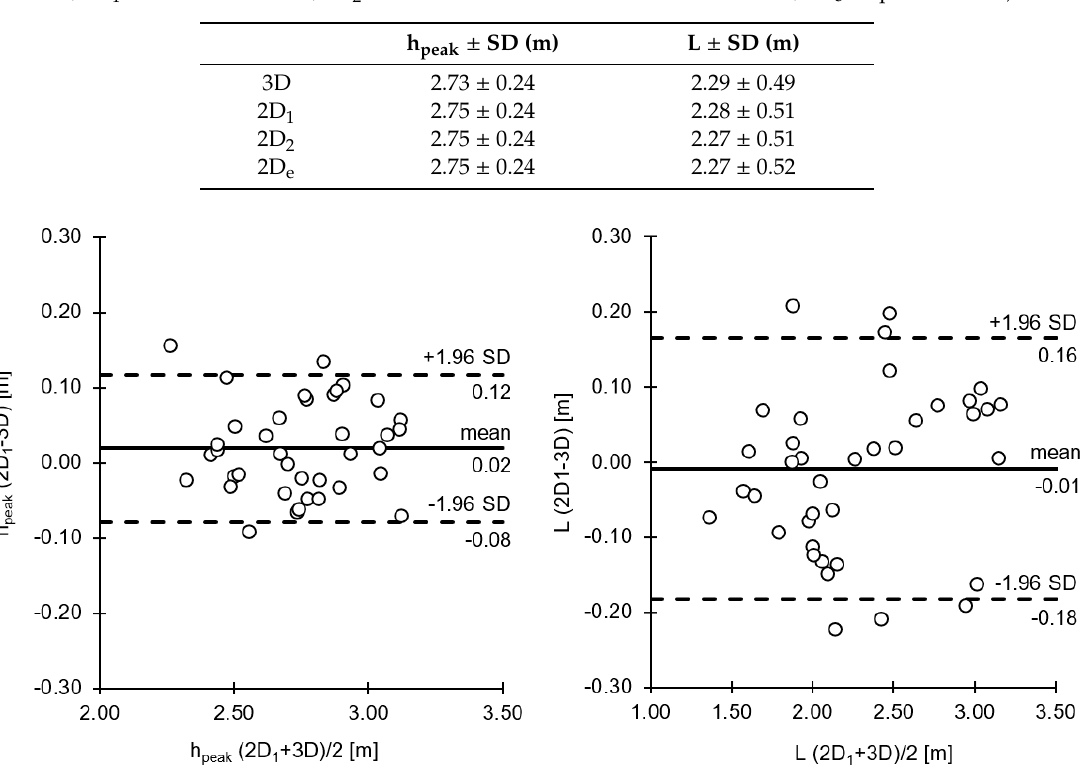
Table 1. Mean ( ± standard deviation) of peak height (h peak ) and length of flight (L) of all recorded vaults (n = 38) for 3D (Vicon Motion System, Denver, USA) and 2D analyses (Dartfish SA, Fribourg, CH; 2D 1 : first-time assessor; 2D 2 : second measurement of first-time assessor; 2D e : expert assessor).